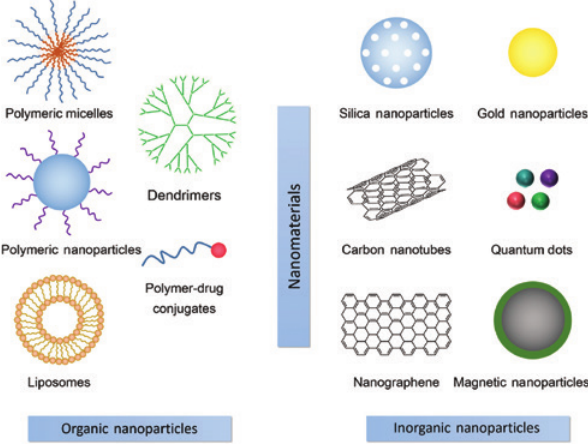
Figure 1: Representation of nanomaterials, including organic and inorganic nanoparticles, applied for cancer